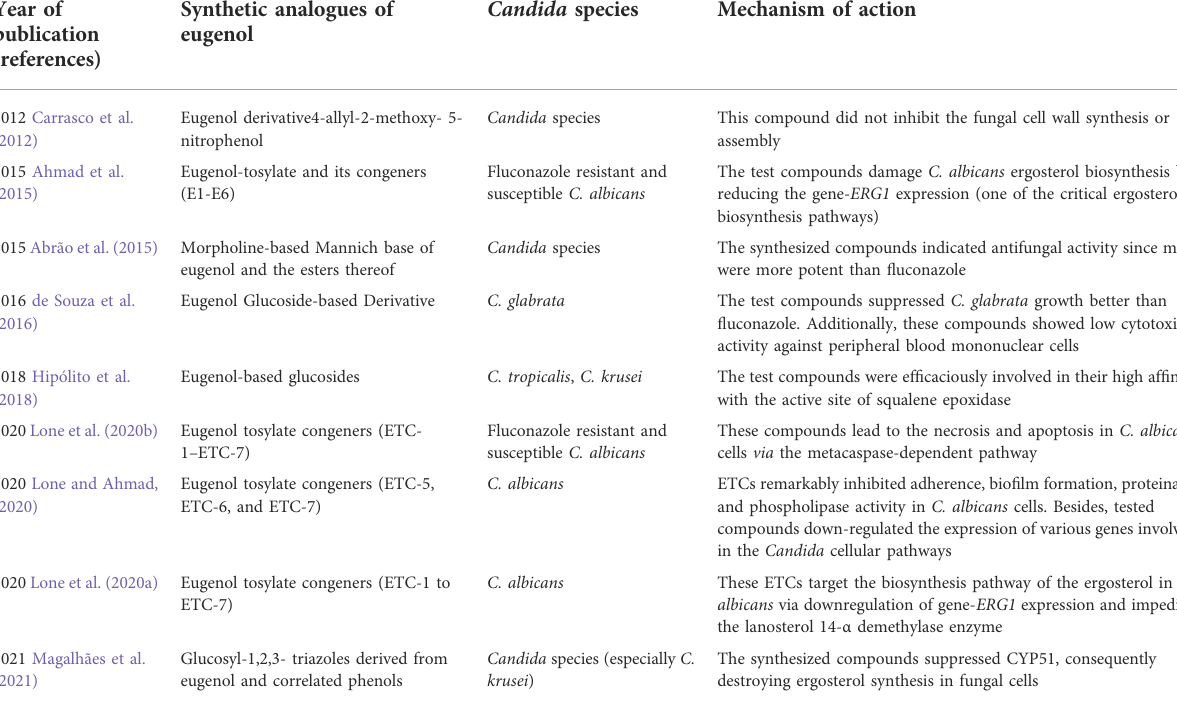
TABLE 2 Studies reporting synthetic analogues of eugenol to inhibit growth and Candida cells ’ cellular